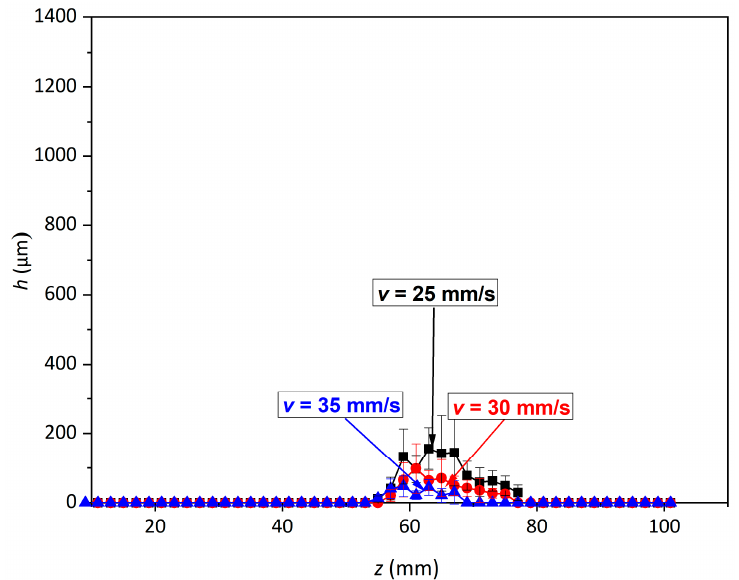
Figure 4. Erosion depth variation with z (5–101 mm) and v (25 (800 impacts/mm) to 35 mm/s (570 impacts/mm)).